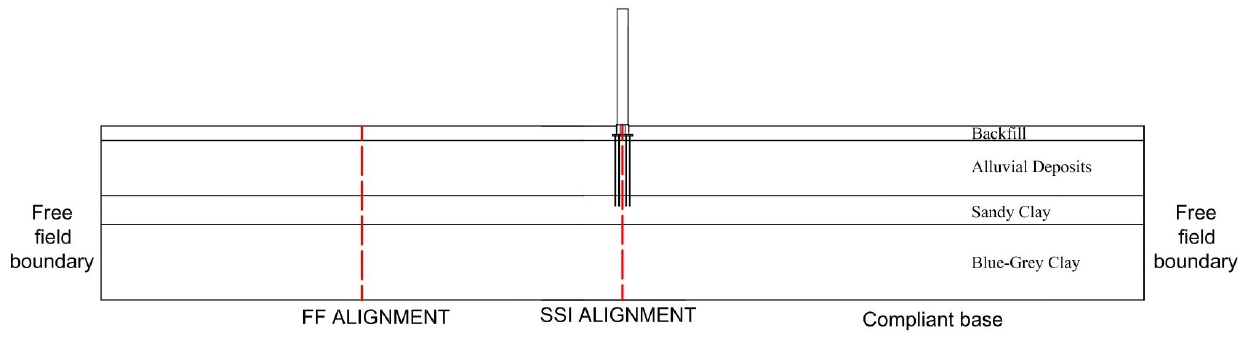
Figure 19. Vertical alignments: along the structure (SSI) and far from the structure (FF).